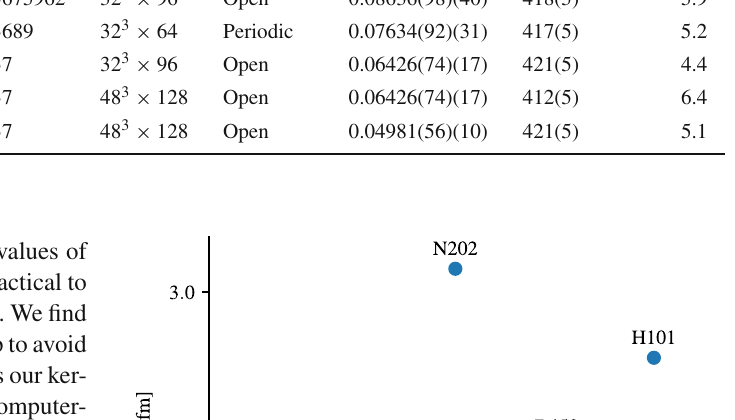
Table 2 Lattice ensembles with SU ( 3 ) f -symmetry used in this work. Each ensemble is parametrized by the gauge coupling parameter β , the quark hopping parameter κ , the lattice size, and the temporal boundary condition. The lattice spacing a was determined in Ref. [22]